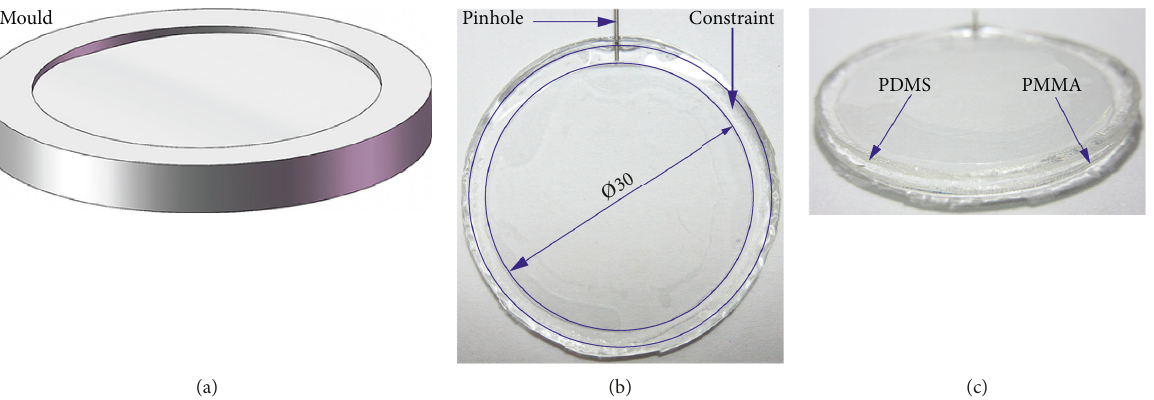
Figure 8: Liquid lens with the nonuniform thickness PDMS membrane. (a) Mold. (b) Front view. (c) Side